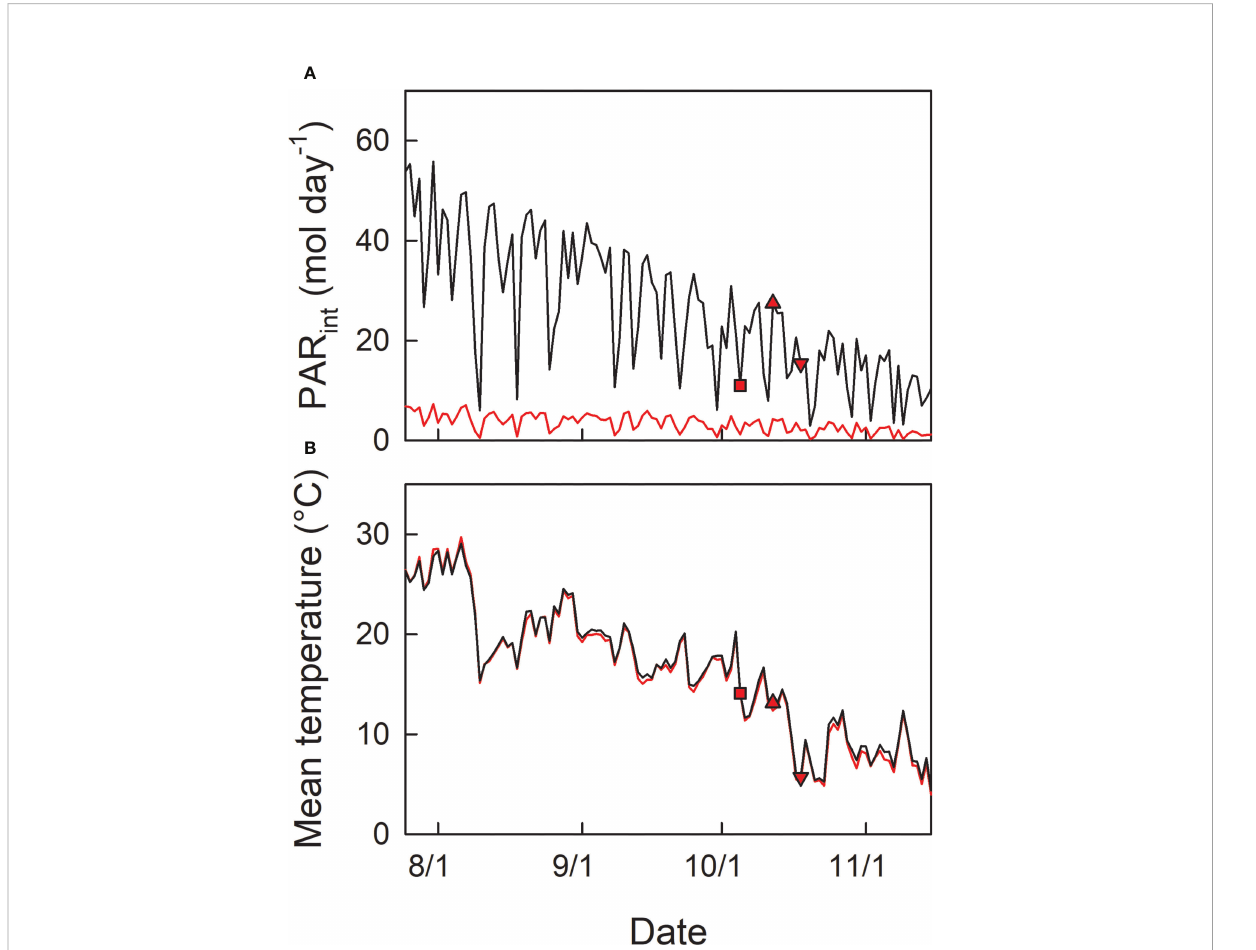
FIGURE 2 Seasonal changes in daily integrated photosynthetically active radiation (PAR int ) (A) , and daily mean temperature (B) in open (black line) and shade (red line) conditions. Red symbols indicate the date of transfer of shade-grown seedlings to the open condition; LH1 (square): 5 th Oct, LH2 (triangle-up): 12 th Oct, and LH3 (triangle-down): 18 th Oct,